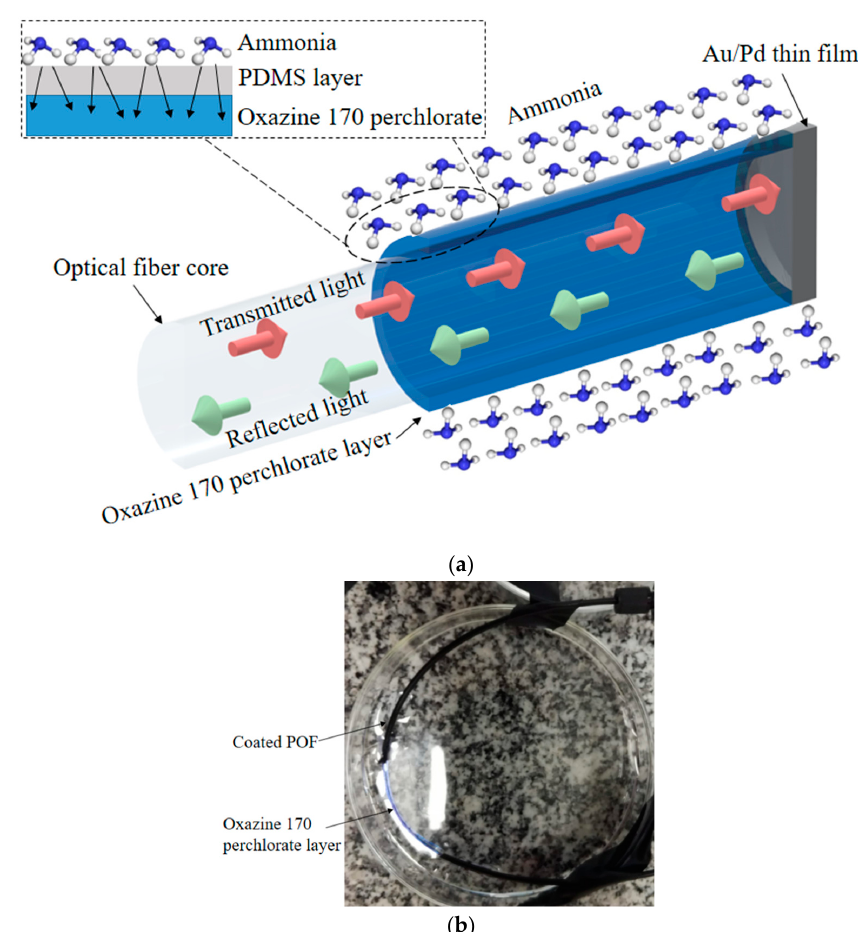
Figure2. ( a )Operationprincipleoftheproposedsensors. Thearrowsareonlyaschematicrepresentation, since the polymer optical fiber (POF) used had multiple propagating modes instead of just the ones presented in the figure. Figure inset shows ammonia di ff usion in the sensing layer. ( b ) Photograph of the proposed sensor (Sample